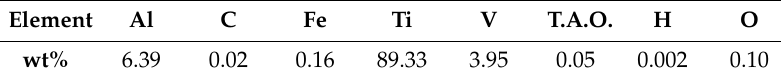
Table 2. Chemical analysis of the Ti6Al4V ELI